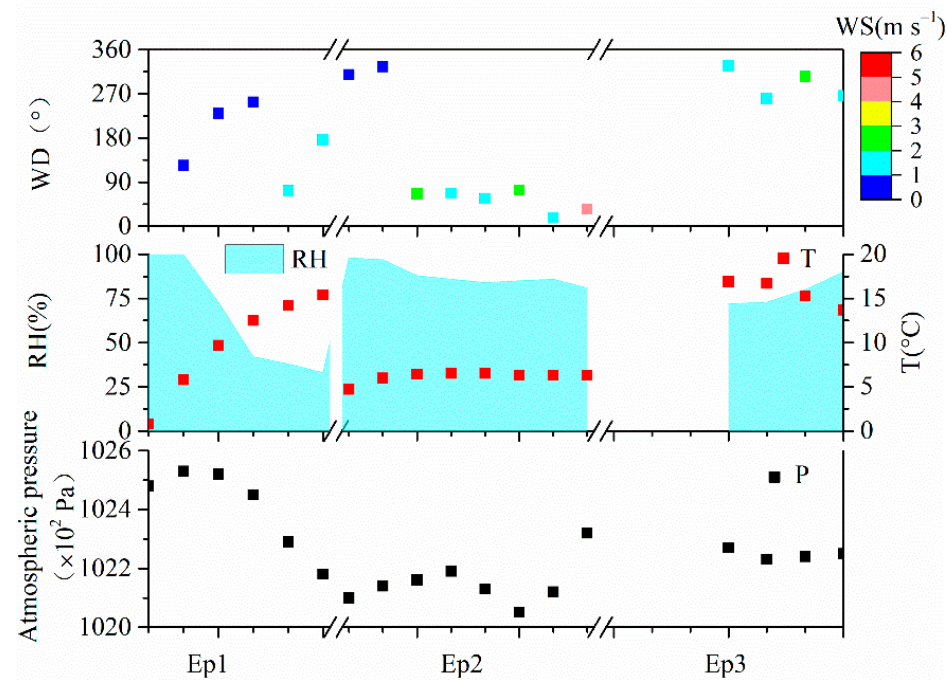
Figure 5. Time trend of PM 2.5 , chemical components, and gas compounds during EG.